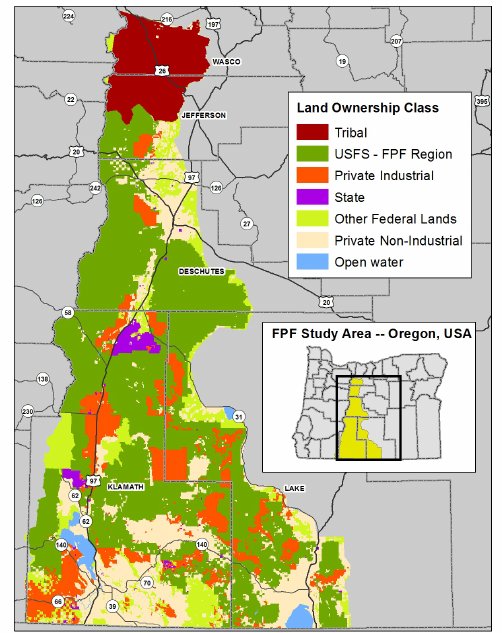
Fig. 1. Land ownership pattern (2010) of study area in east Cascades Oregon,